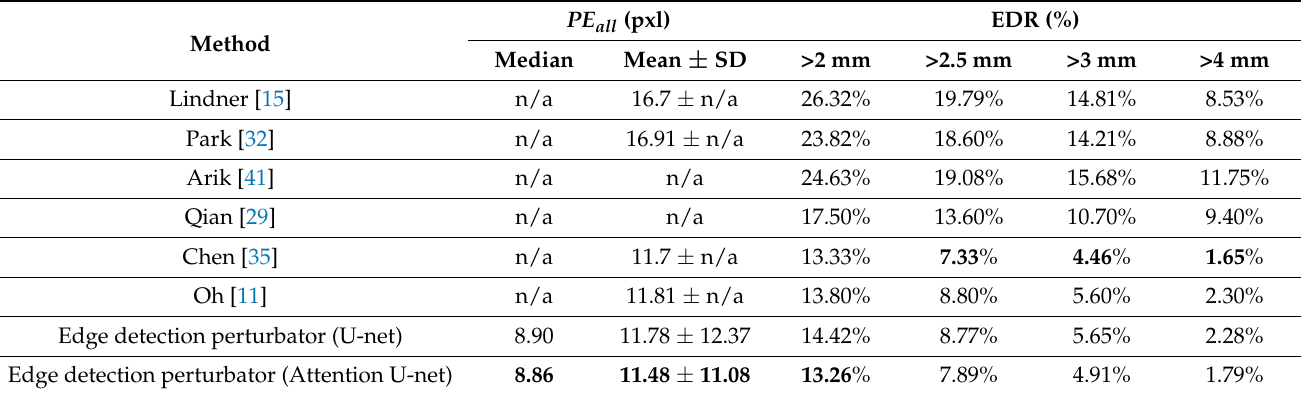
Table 6. Quantitative comparison with existing methods on the ISBI 2015 dataset (test1).